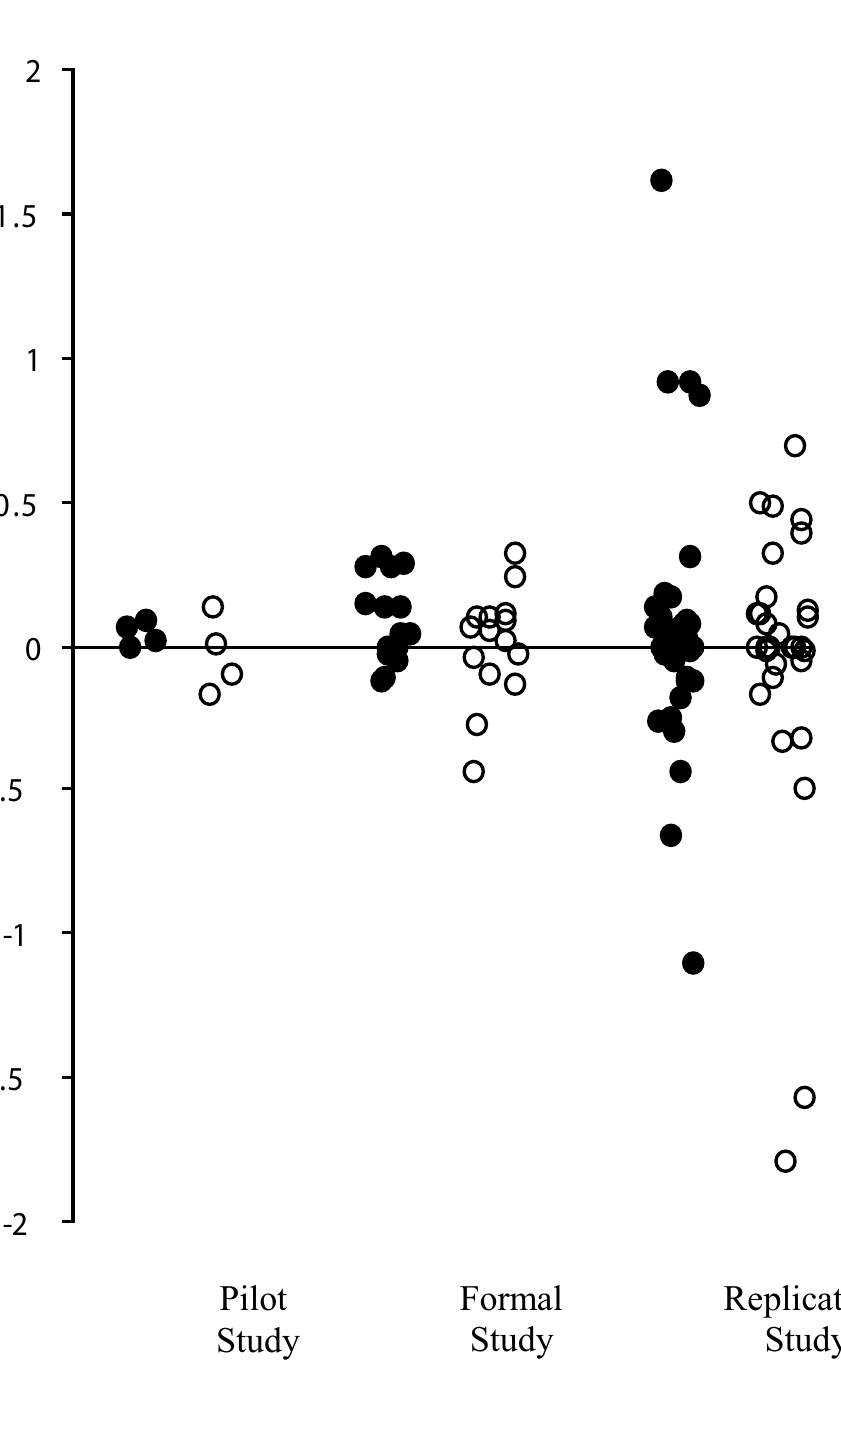
Figure 1 Colony forming efficiency ratios for three studies. Natural Log Qigong/sham ratios are graphed for all experiments in the pilot study (left), the first formal study (middle) and the replication study (right). Qigong/sham ratios are shown as solid circles ; sham/sham ratios are shown as open circles